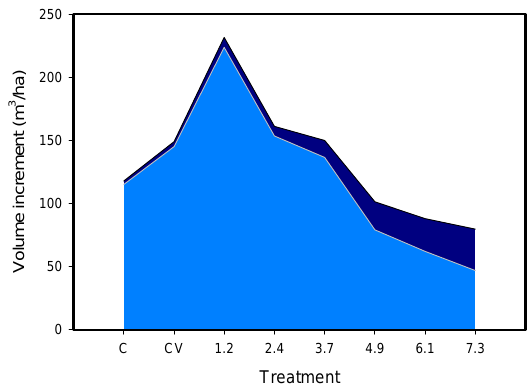
Figure 4. Volume increment from 2001–2012 by treatment (average spacing in meters) showing the added increment from ingrowth (dark blue). The treatments included two types of controls (C = no thinning; CV = no thinning and herbicide treatment of shrubs), and the target spacings from 1.2 to 7.3 m (4 to 24 feet) (adapted from [75]).